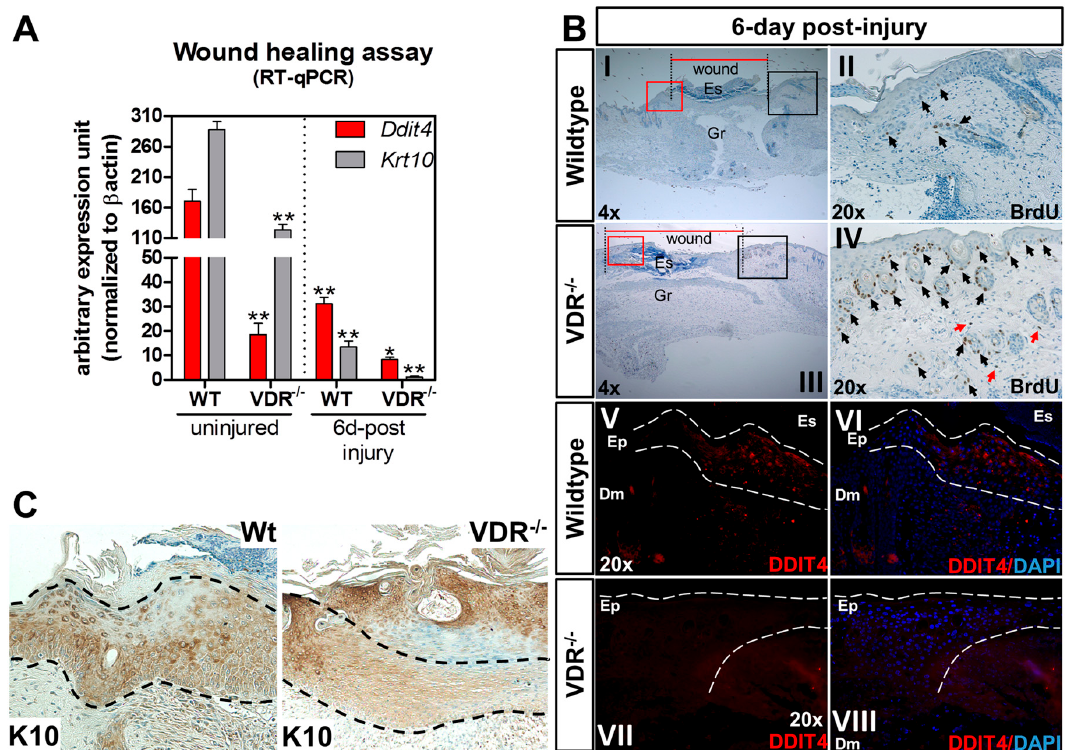
Figure 5. Reduction of Ddit4 in the re-epithelized wounds of VDR − / − animals (column 1.5). ( A ) RT-qPCR analysis of the wound repair process from excised wounds. For uninjured samples, comparisons were made between genotypes. Six days following injury, sample comparisons were made between the respective uninjured genotypes. One-way ANOVA at an α = 0.05 (95% confidence interval) and Tukey’s multiple comparison post-tests were utilized. Significance is denoted with asterisks: * p < 0.05, ** p < 0.01 ( n = 4 samples per genotype and time point); ( B ) Representative slides showing 5-bromo-2 ′ -deoxyuridine (BrdU) immunohistochemical ( I – IV ) and Ddit4 immunofluorescence ( V – VIII ) staining of WT and VDR − / − skins six days following injury. Wound closure is depicted by the horizontal red bars. Black boxed areas in the 4× slides represent the BrdU-labeled magnified regions ( II and IV ). Red-boxed areas represent the Ddit4-labeled magnified regions ( V – VII ). In the BrdU slides, black arrows depict proliferating epidermal and follicular keratinocytes. Red arrows depict proliferating dermal fibroblasts. In the Ddit4 panels, the dotted white line marks the re-epithelialized area. Nuclei are marked in blue with 4 ′ ,6-diamidino-2-phenylindole (DAPI), while Ddit4 is labeled in red . ES: eschar; GR: granulation tissue; EP: epidermis; DM dermis; ( C ) Krt10 immunostaining within the neo-epidermis (demarcated by dashed lines) six days following injury.